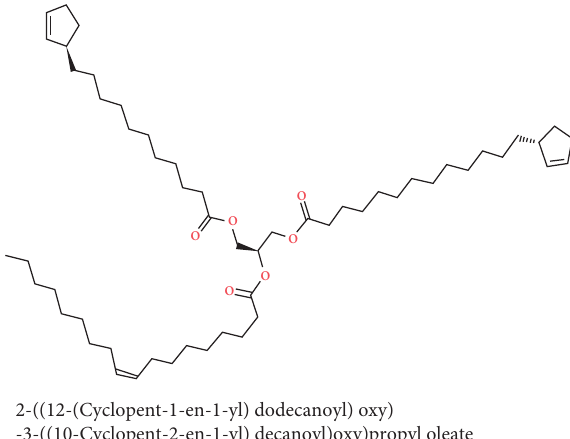
Figure 4: Typical molecular structure of chaulmoogra oil with IUPAC name.